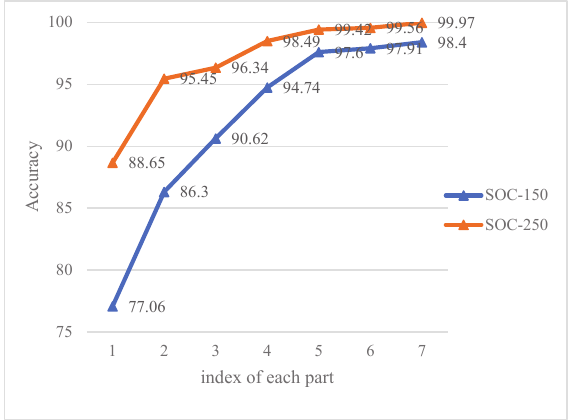
Figure 11. Diagram of recognition accuracy of ablation experiments.